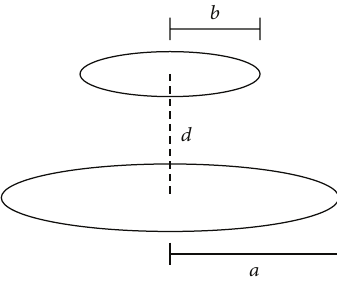
Figure 2: Two coaxial coils with radii 𝑎 and 𝑏